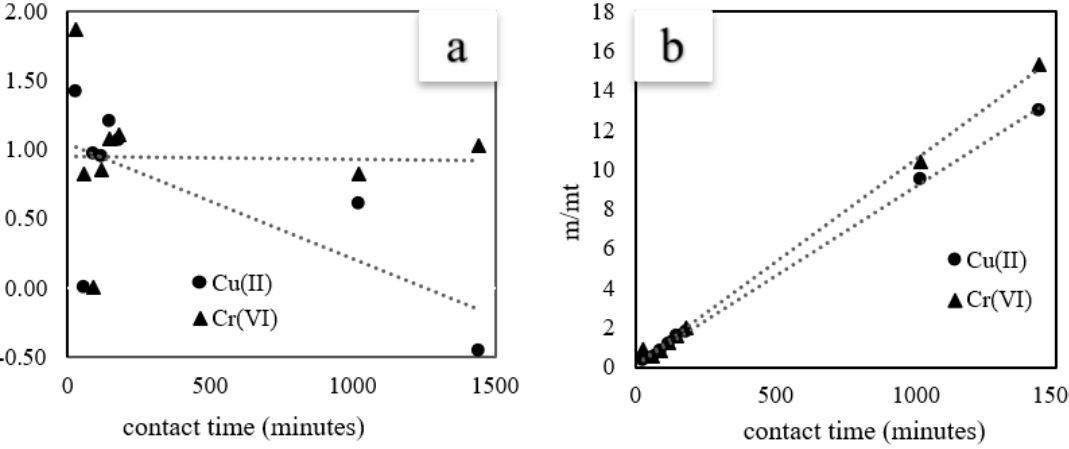
Figure 7. Linear curves of adsorption kinetic studies. ( a ): pseudo- fi rst order, ( b ): pseudo-second or-